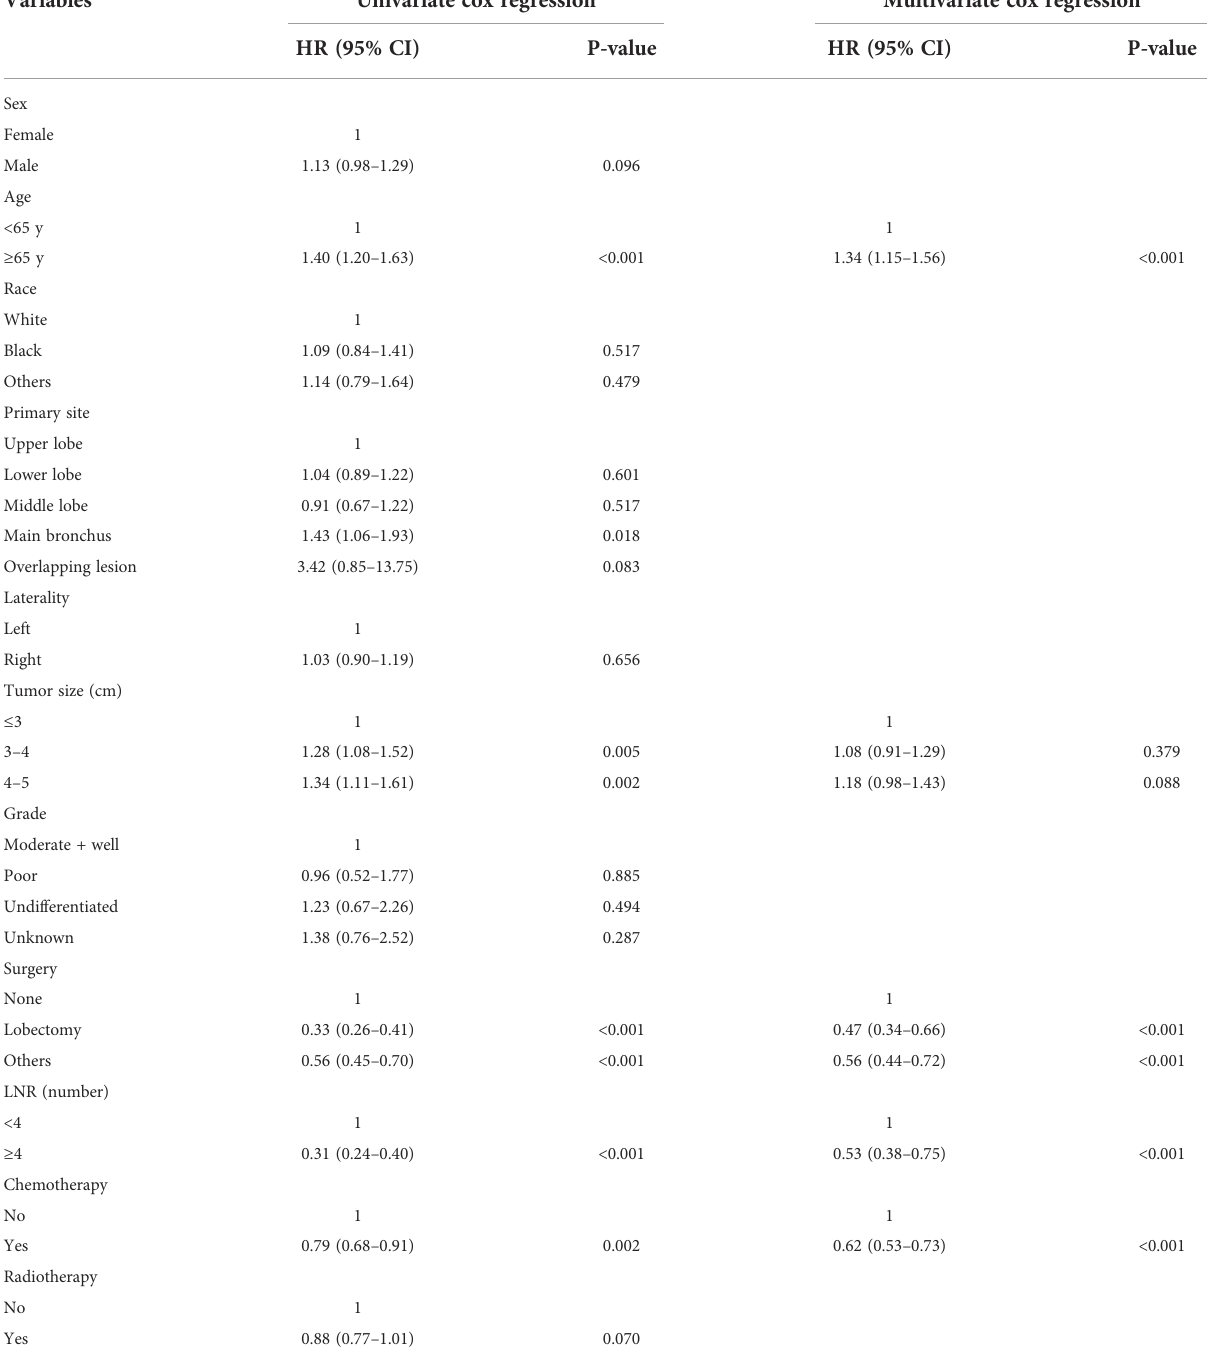
TABLE 3 Univariable and multivariate Cox proportional hazards regression analysis for lung cancer-speci fi c survival. Variables Univariate cox regression Multivariate cox